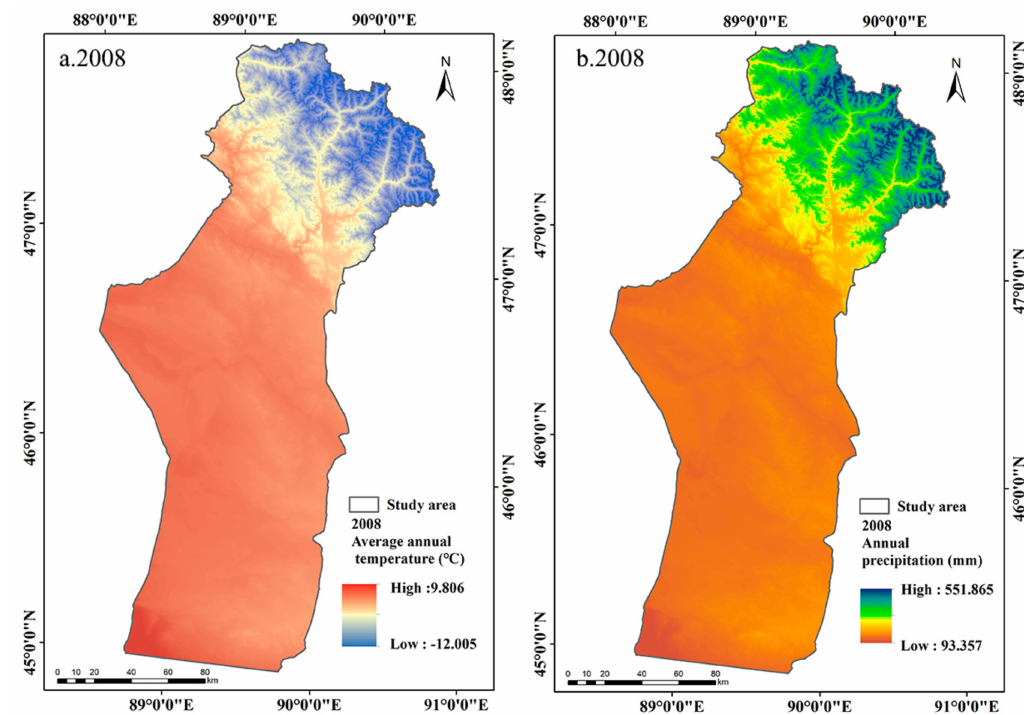
Figure 9. Spatial distribution of average temperature and annual precipitation in 2008.